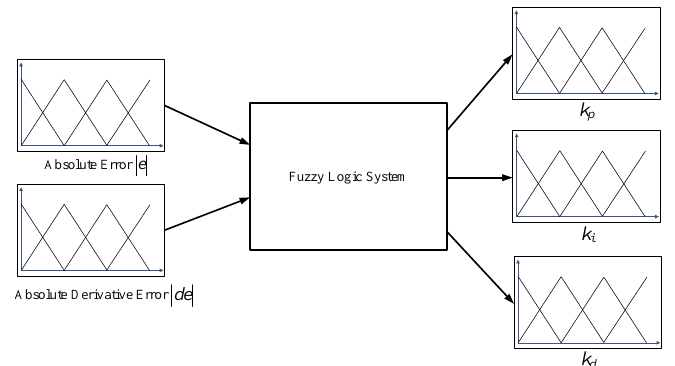
Figure 4. Fuzzy design for tuning parameters ( K p , K i , K d ).